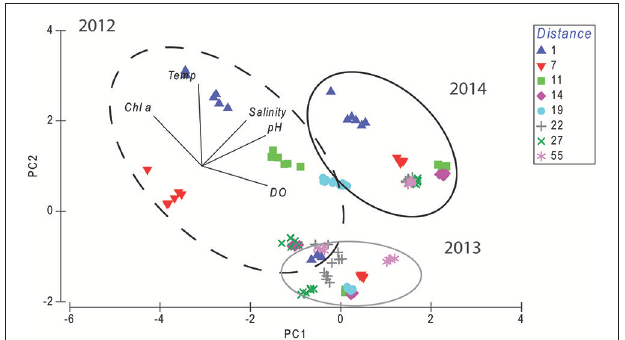
FIGURE 3 | Principal component analysis of environmental data from water quality variables Chl a , DO, temperature (Temp), salinity, and pH, indicated for each site as distance from shore in years 2012, 2013, and 2014. Principal components 1 and 2 are used in subsequent multivariate GLMs of benthic communities (scores listed in Table S4).